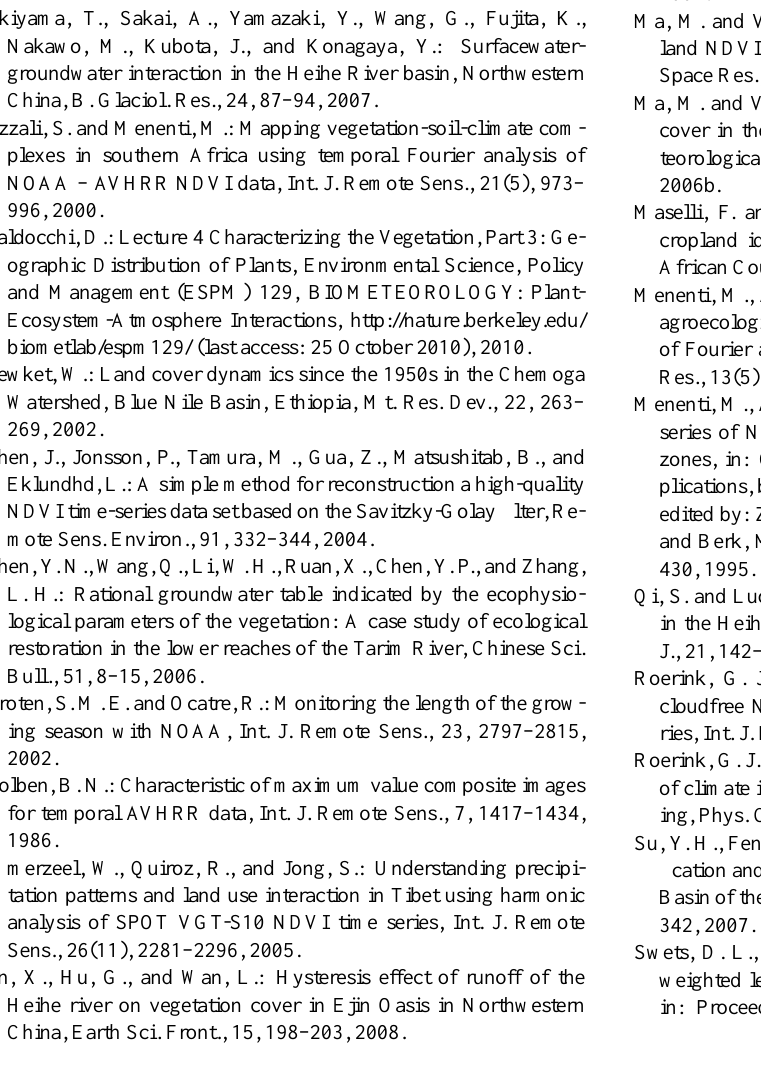
L. H.: Rational groundwater table indicated by the